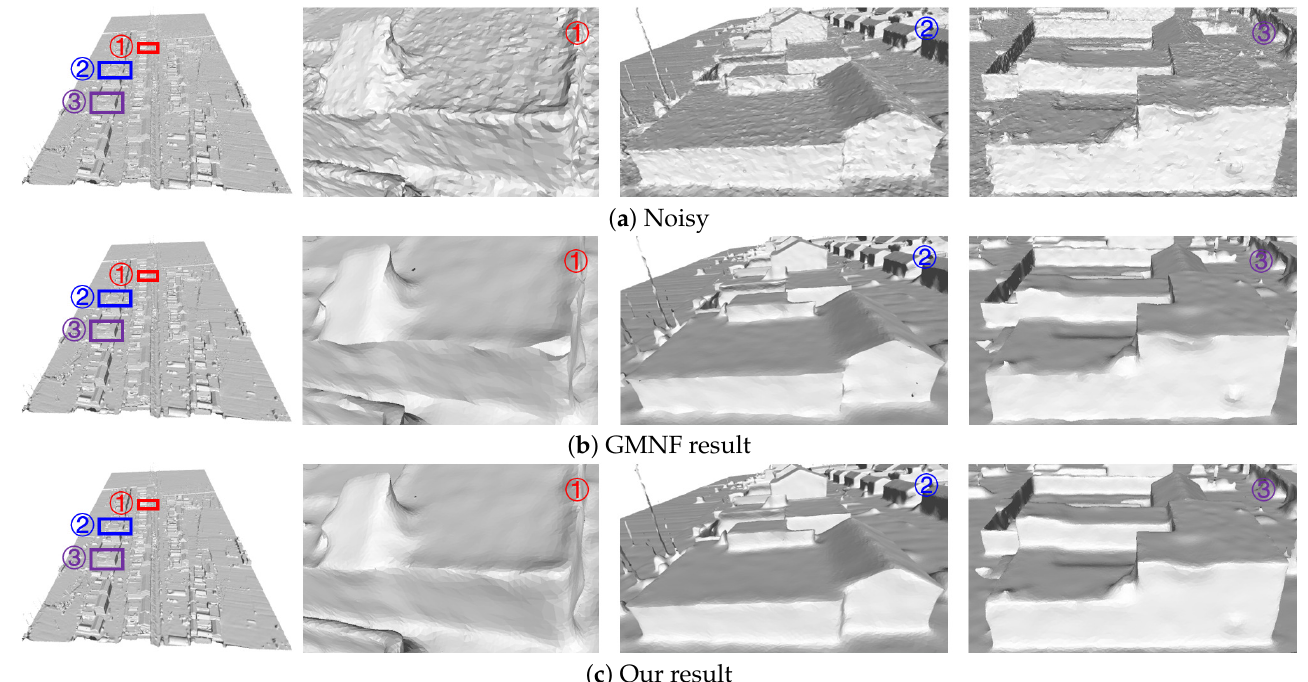
Figure 17. Comparison of the denoising results for the Village model reconstructed from oblique images.